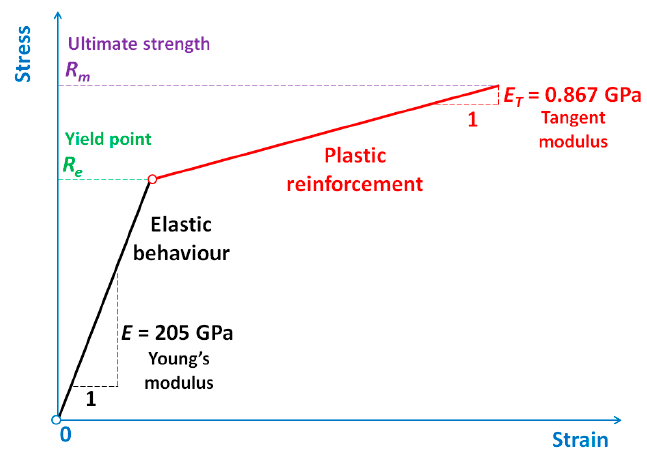
Figure 1. Bilinear material model.